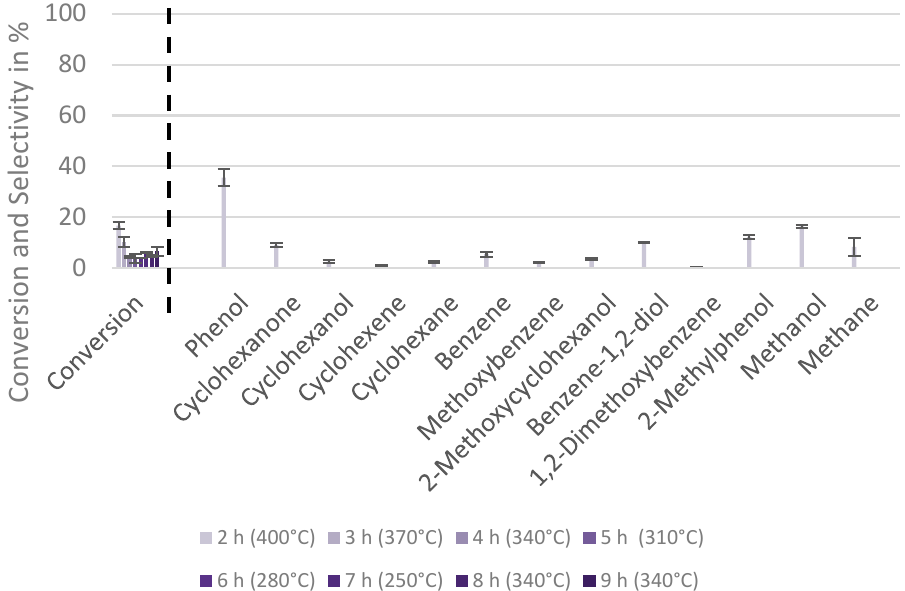
Figure A10. P-XRD of calcined silver catalyst before reaction (calc.) and after reaction.